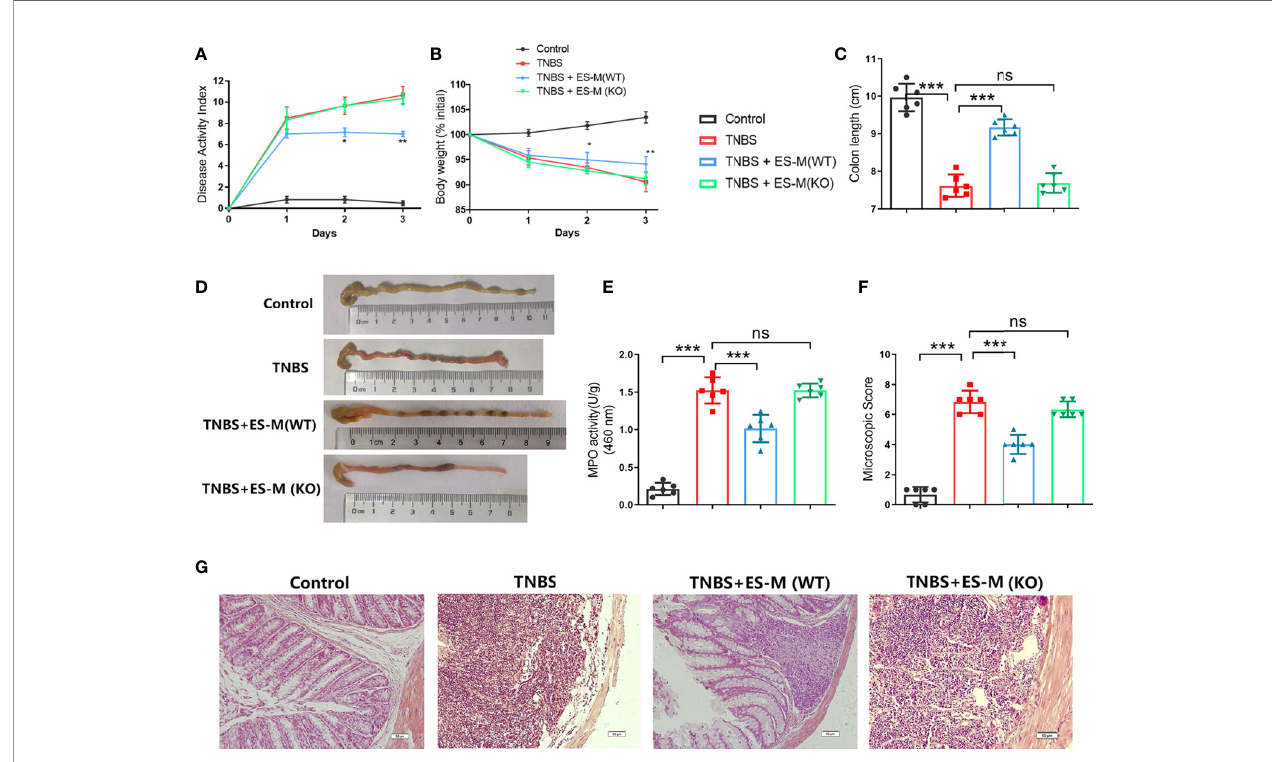
FIGURE 4 | Effect of T. spiralis ES – induced wild type (WT) or Nrf2 KO macrophages (ES-M) on TNBS-induced colitis. For adoptive transfer, WT or Nrf2 KO macrophages induced by T. spiralis ES were washed (x3) with sterile PBS, and 1 × 10 6 cells in 500 m L of sterile PBS were injected intravenously (i.v.) after TNBS challenge. Three days later, colitis was induced by TNBS in these recipient mice. Mice were humanely euthanized by CO 2, and then the colon and spleen were collected for the following experiments. The protective ef fi cacy against TNBS challenge was determined in three independent experiments. One representative experiment is shown here. (A) Disease activity index (DAI) was measured during the disease process. (B) The daily mean weight change in each group was calculated. (C, D) After 3 days, colons were removed, and the lengths of their colons were measured and recorded. (E) Myeloperoxidase (MPO) activity in the colonic tissues was detected. The colonic segments were stained with hematoxylin and eosin (H.E.) staining according to standard protocols. (F) The colons from each experimental group (n=6) were processed for histological evaluation (200×). (G) Histopathological damage scores were determined for the colon tissue samples. The results are representative of at least three independent experiments and expressed as the mean±SD of each group (n=6). ***P < 0.001, ns, no signi fi cance, as indicated by line (one-way ANOVA with Tukey ’ s posttest) on the same